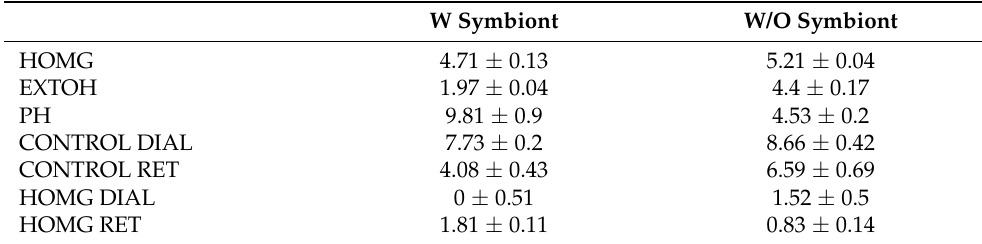
Table 3. Free radicals’ uptake/retention of different samples obtained from Anemonia sulcata . W Symbiont W/O